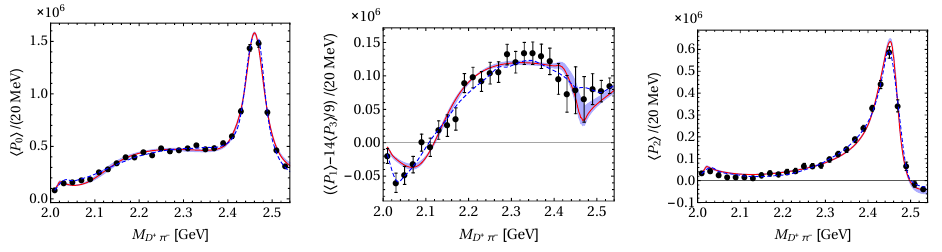
Figure 2. Fit to the LHCb data for the angular moments (cid:104) P 0 (cid:105) , (cid:104) P 1 (cid:105) − 14 (cid:104) P 3 (cid:105) / 9 and (cid:104) P 2 (cid:105) for the B − → D + π − π − reaction [69]. The solid lines are the best fit results, with error bands the one-sigma uncertainties propagated from the input scattering amplitudes. The dashed lines represent the LHCb fit [69]. For more details, see Ref.